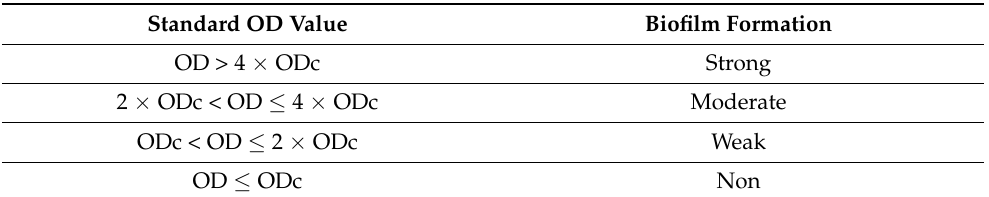
Table 6. Criteria of classification for biofilm